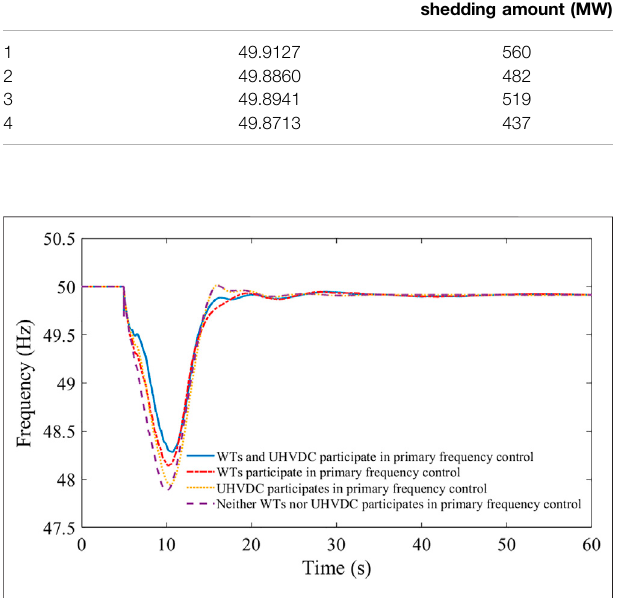
FIGURE 10 | Frequency curves under different UFLS schemes considering different primary frequency control